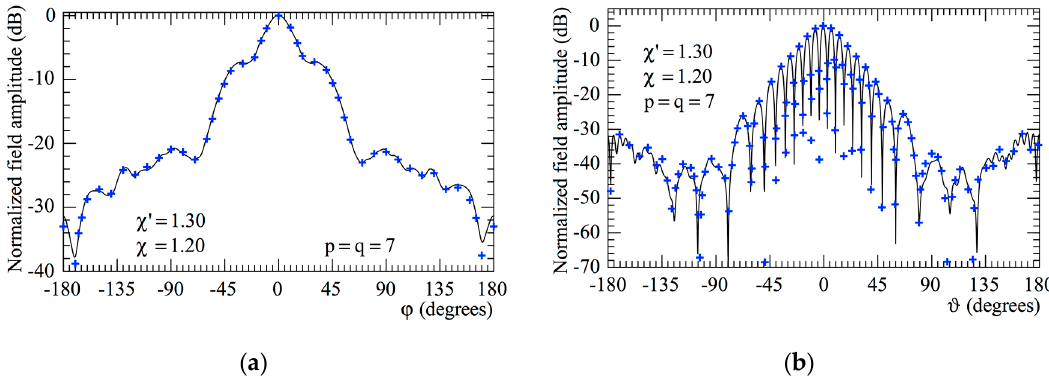
Figure 11. Far-field pattern ――― reference obtained when mounting the AUT in a centered configuration. + + + + interpolated from the non-redundant samples: ( a ) E-plane; ( b ) H-plane.